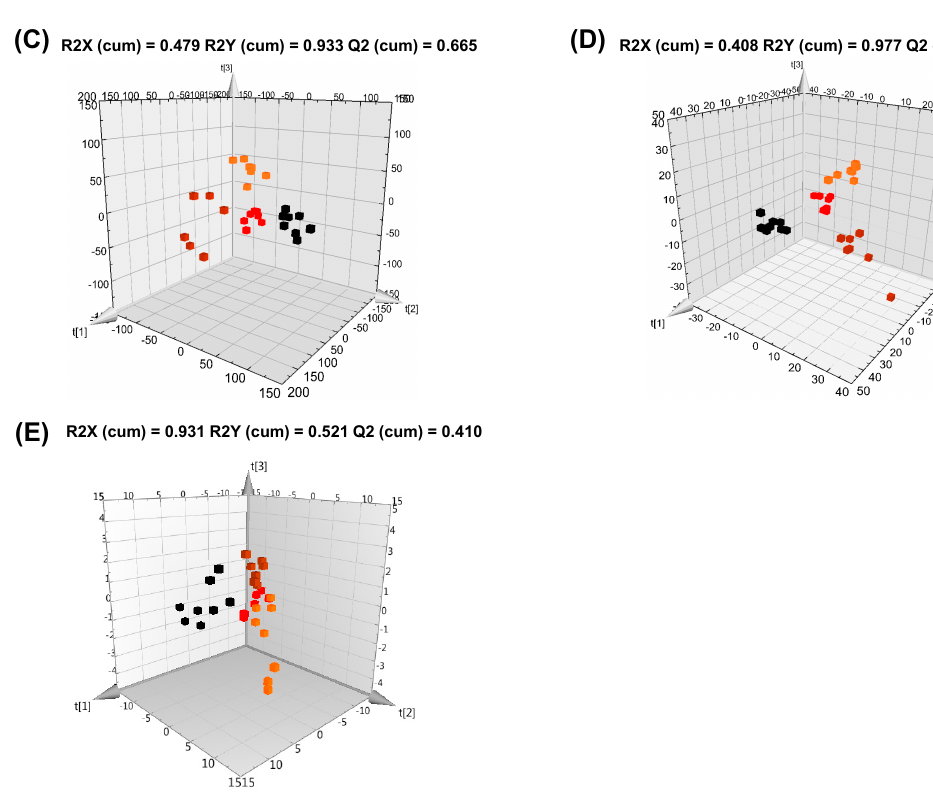
Figure 2. Three dimensional (3D) PLS-DA score plots derived from GC-TOF-MS ( A , C ) and UPLC-Q-TOF-MS ( B , D ) data sets in negative ion mode for MW ( A , B ) and DM ( C , D ) extracts, and direct infusion nanoelectrospray-MS data set ( E ) of liver in mice fed a High-Fat Diet (HFD) including Platycodon grandiflorum . Black square ND, normal diet; red square HFD, high-fat diet; orange square HPGL, high-fat diet with 1% P. grandiflorum ; brown square HPGH, high-fat diet with 5% P. grandiflorum